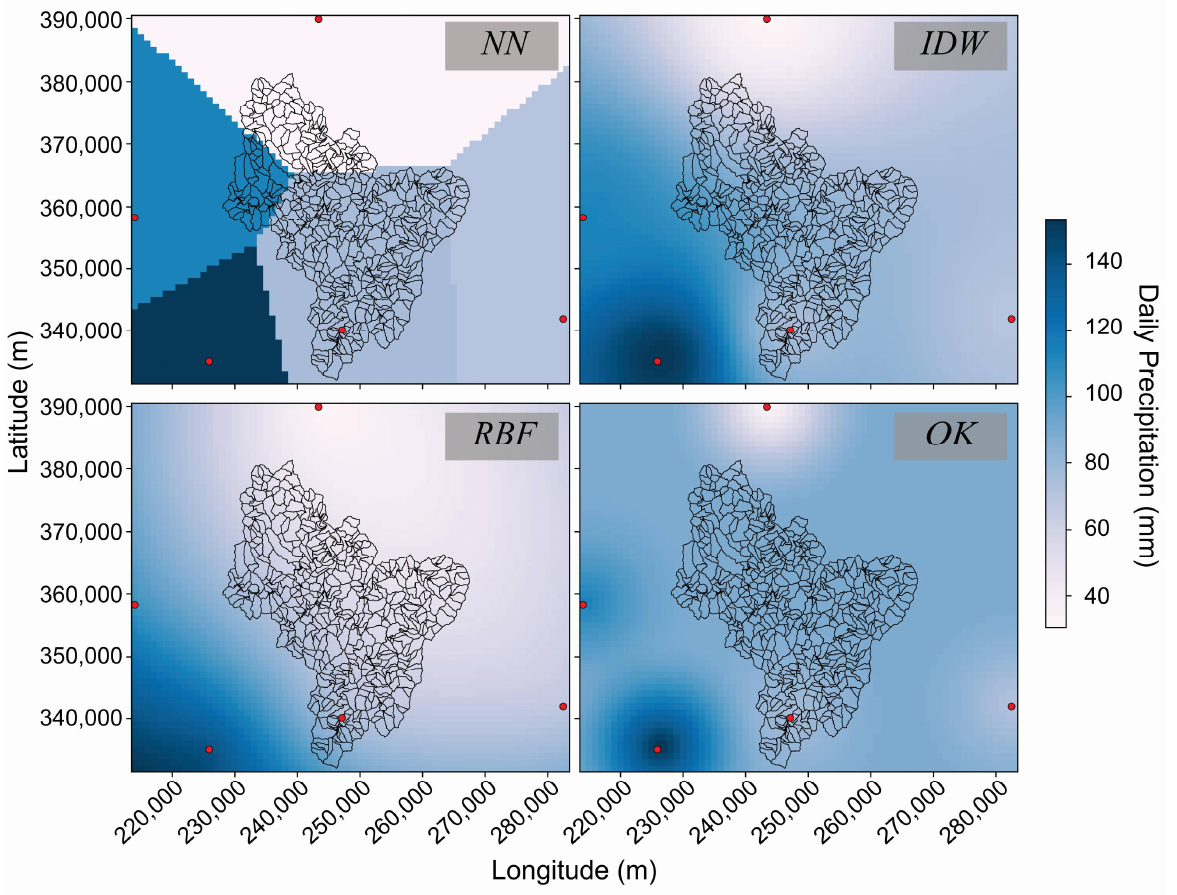
Figure 1. Comparison of all spatial interpolation methods utilized in this study (red markers show the location of all observation stations considered) for the same event.